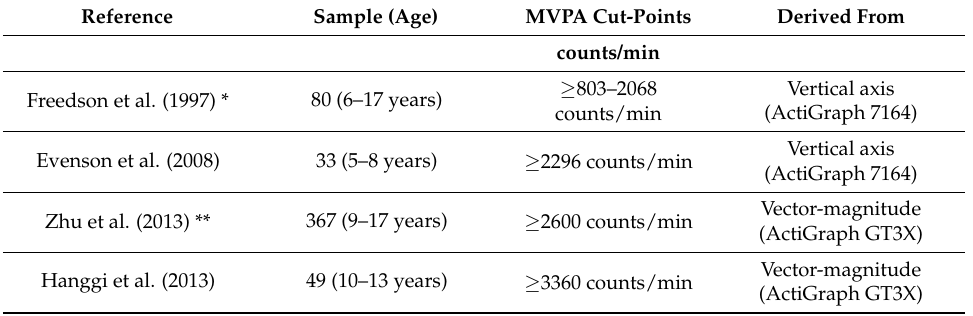
Table 1. Cut-points for Classifying Children’s moderate-vigorous physical activity (MVPA).